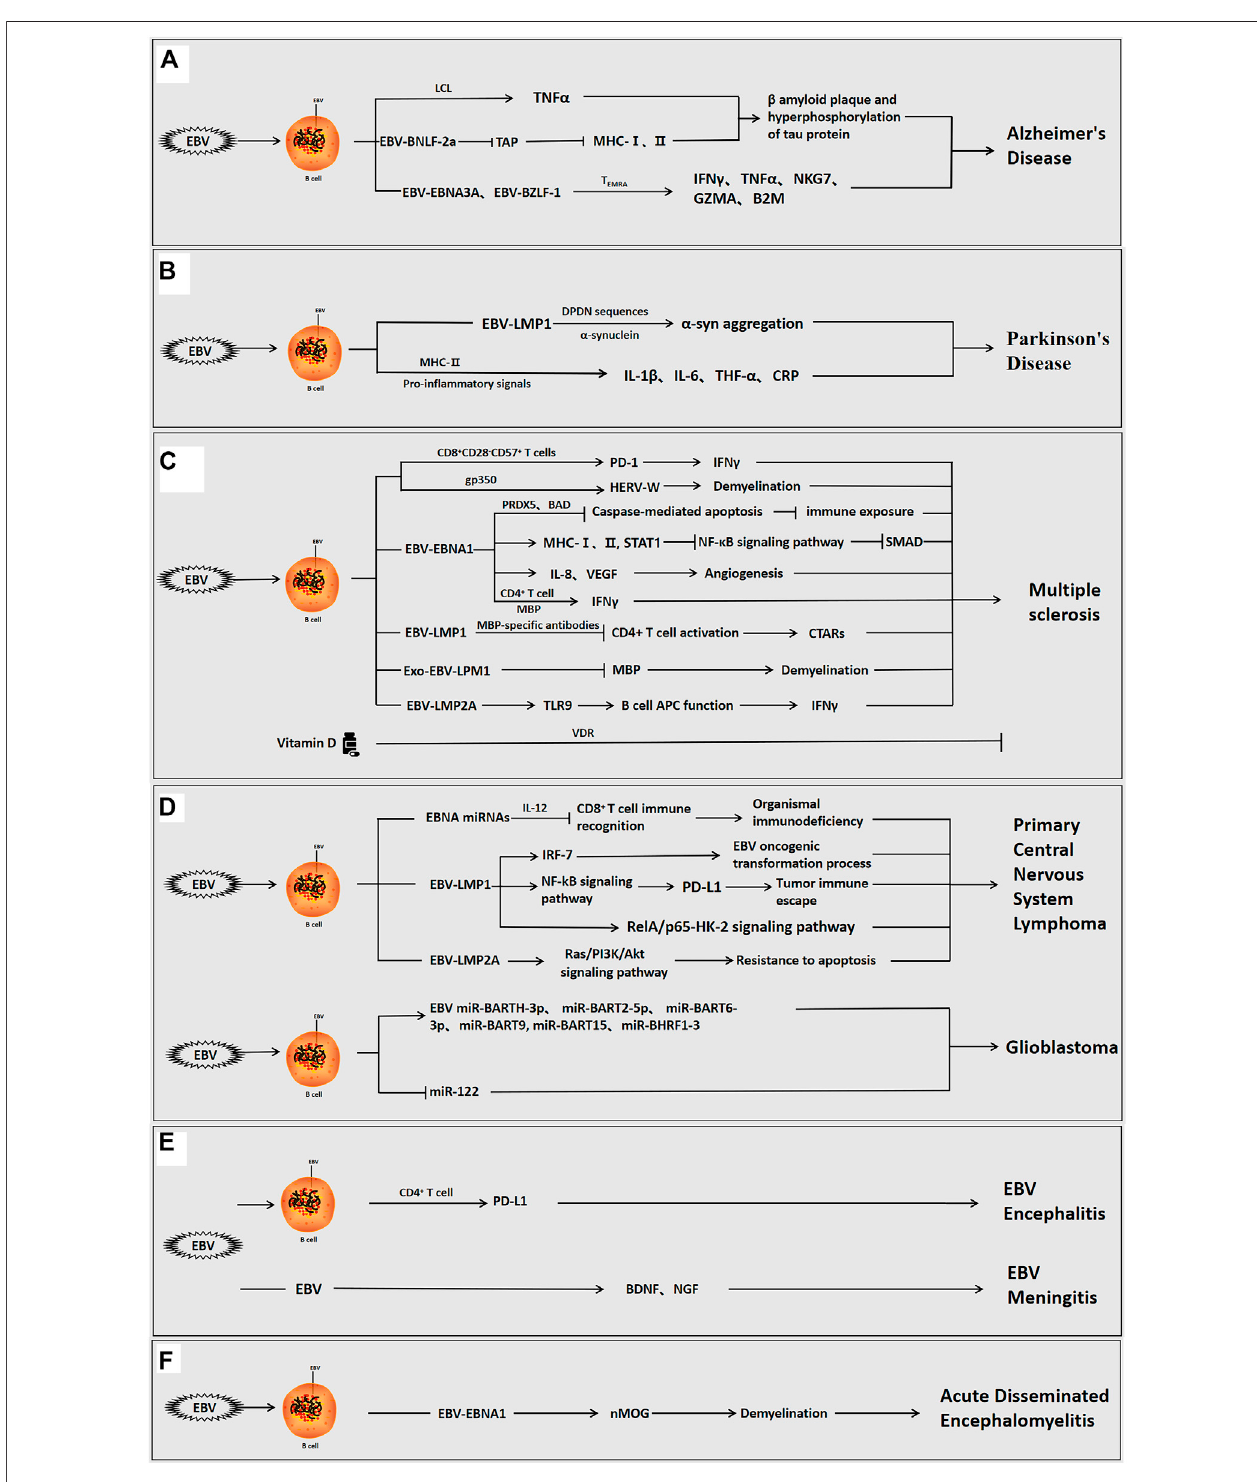
FIGURE1| TheroleofEpstein-barrvirusinneurologicaldiseases.EBVcaninfecttheorganismdirectly,orindirectly via infectionofBcellsinteractwithhostcells via its ownencoded proteins(EBNA1,LMP1,LMP2A, etc.)andmiRNAstopromotein fl ammation andregulatetheimmune response, andparticipateinthedevelopmentof neurological disorders. (A) EBV-positive/infected B cells used the viral proteins to induce β -amyloid aggregation and tau protein hyperphosphorylation, cause neuroin fl ammation and modulate the immune response, and promote the development of AD. (B) EBV-infected B cells used the viral proteins to induce α -syn aggregation,causeneuroin fl ammation,andpromotethedevelopmentofPD. (C) EBV-positiveBcellsusedtheviralproteinstoinduceangiogenesis,neuroin fl ammation,